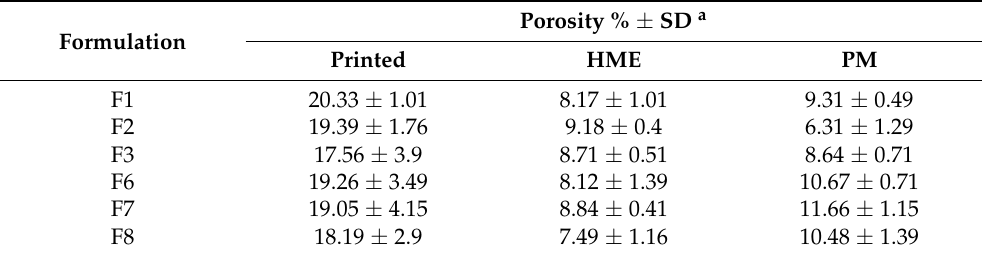
Table 8. Porosity of tablets made via different